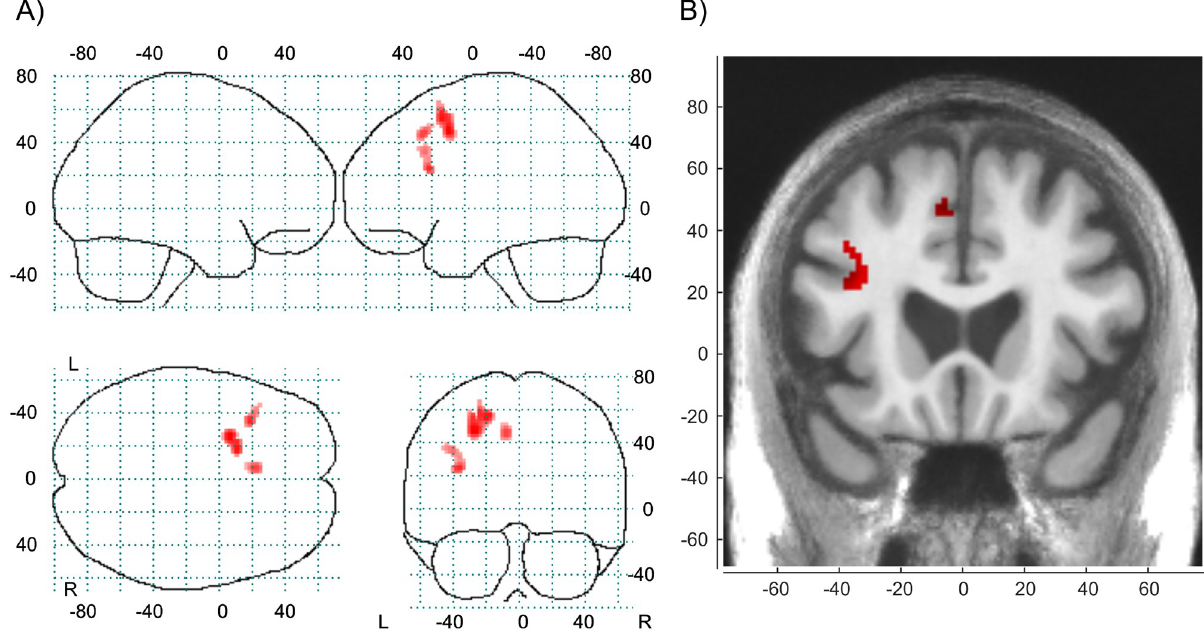
Fig 2. Load-dependent working memory network. Working memory load effect. 3-back show stronger BOLD-response than 1-back at placebo with a voxel threshold at p (uncorrected) < 0.001, cluster size � 10 voxels. (A) Glass brain. (B) Slice image at y = 20.